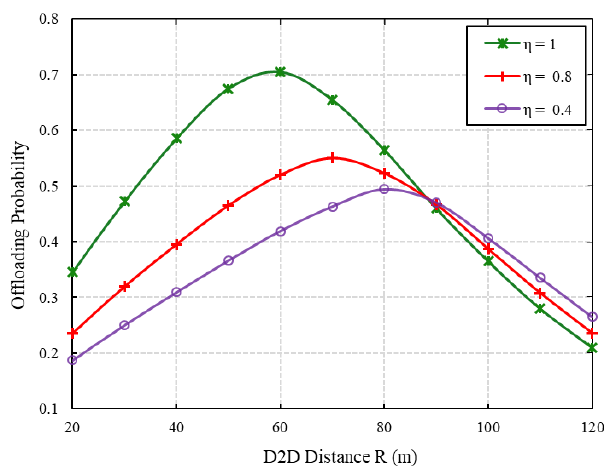
Figure 3. Comparison of offloading probability versus D2D distance R with different values of the Zipf parameter η .